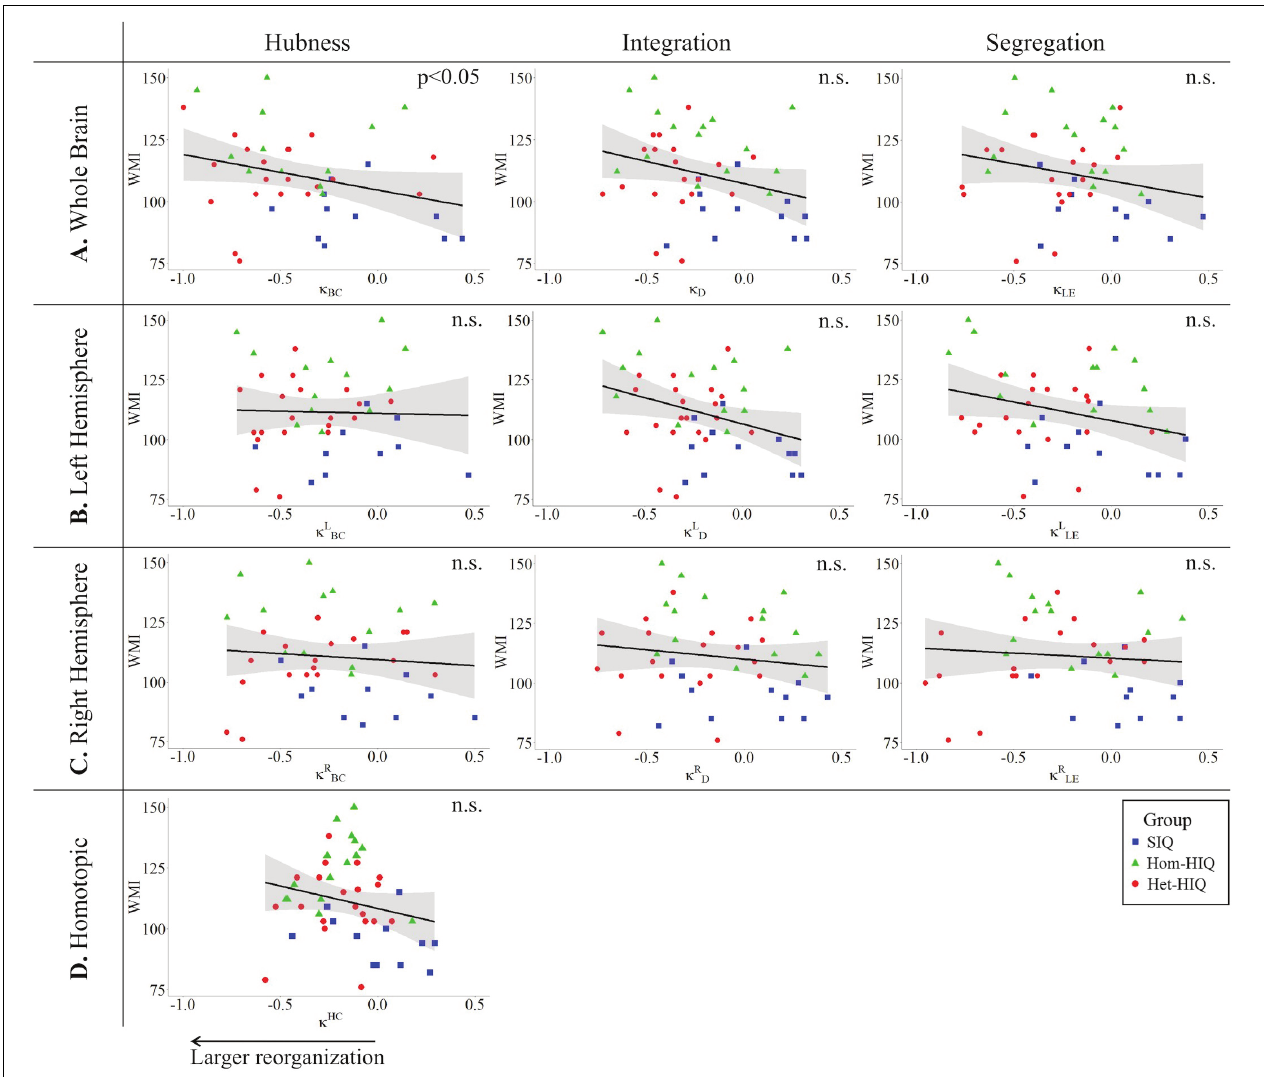
FIGURE 5 | Correlations between working memory index (WMI) and hub disruption indices ( κ ) of graph metrics measured in: (A) the whole brain networks, (B) the left hemisphere networks, (C) the right hemisphere networks, and (D) the homotopical nodes. Significant correlations were measured for κ describing hubs properties in the whole brain networks ( κ BC